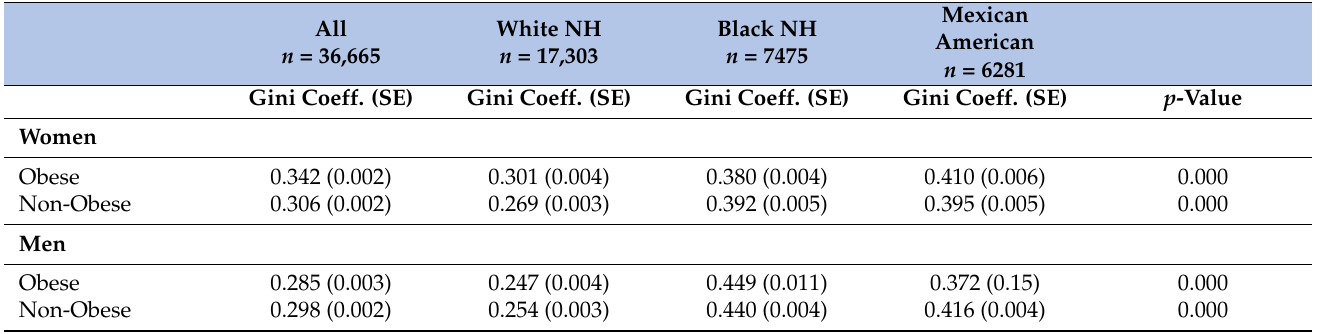
Table 2. Comparing Gini coefficient across racial/ethnical groups and sex in U.S. adults in the 1999–2016. All